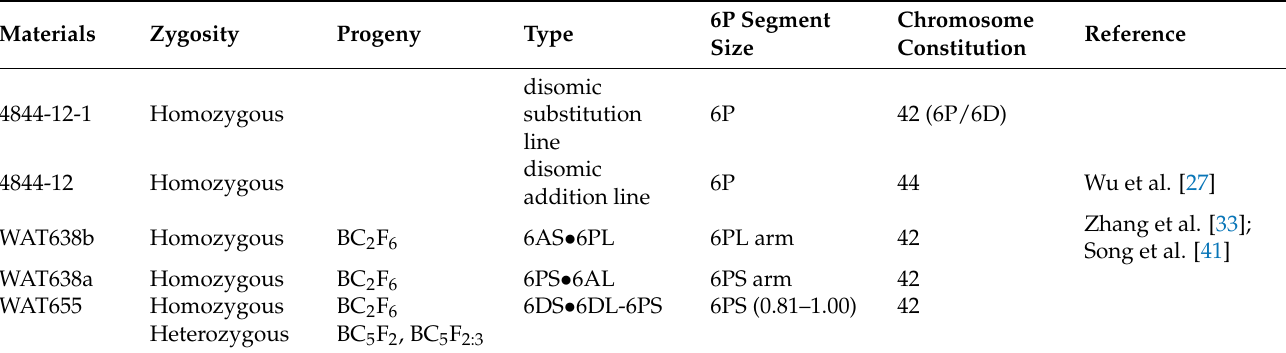
Table 3. The information of the plant